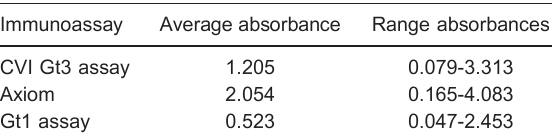
Table 2. Absorbances measured using three different HEV immunoassays for testing a set of 1100 pig sera obtained at slaughter.